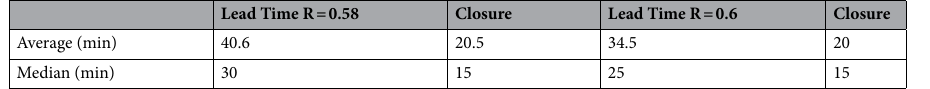
Lead Time R = 0.58